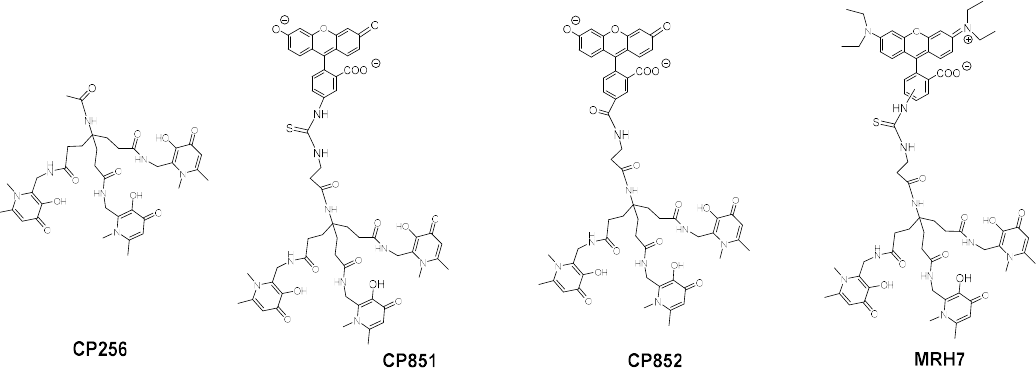
Figure 4. Formulae of 3,4-HPO chelators, CP256 (non-fluorescent ligand), CP851, CP852 (green ligands) and MRH7 (red ligand).